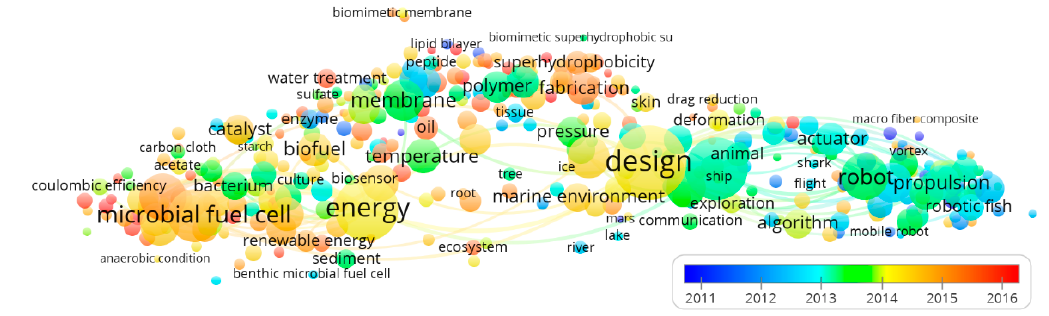
Figure 5. Term-year map based on biomimicking publications. The scale represented the earlier (blue) or more recent (red) years when the term appeared. Terms are represented by a circle (node whose diameter and label size represent the number of publications where the term occurs. Top 100 linkages were represented.